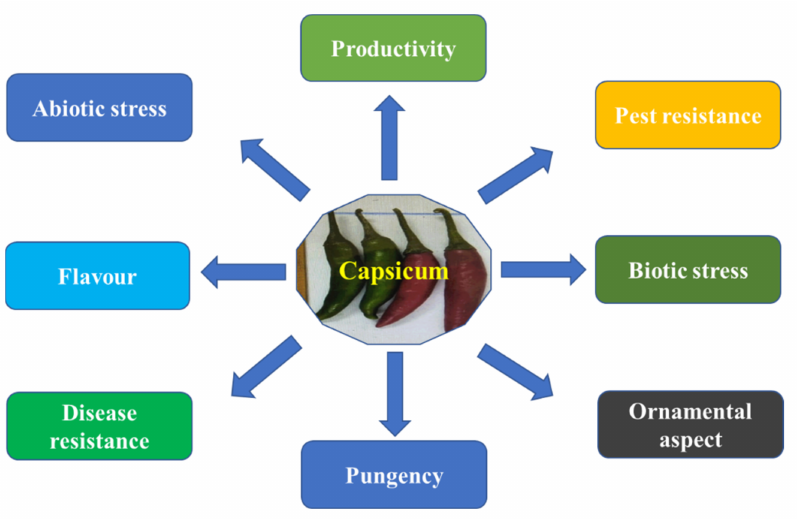
Figure 4. The primary objectives of breeding initiatives for chilli peppers were adopted from